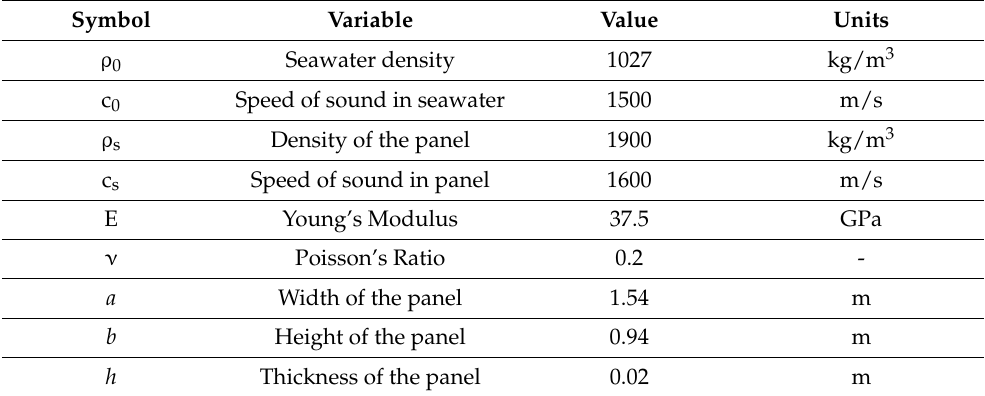
Table 4. Seawater and Panel properties used to estimate the radiation efficiency of the Glass Fibre Reinforced Plastic (GFRP) panel by means of the Maidanik’s and Uchida’s analytical models.